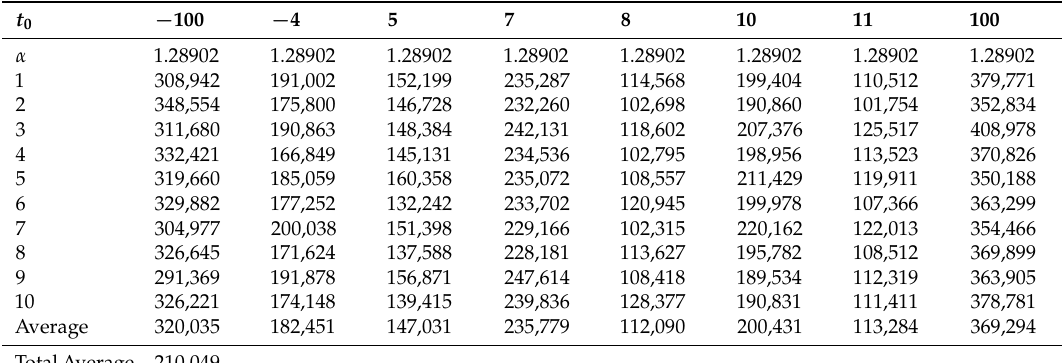
Table 12. Running time for different initial values of Example 5 by the Algorithm [6].